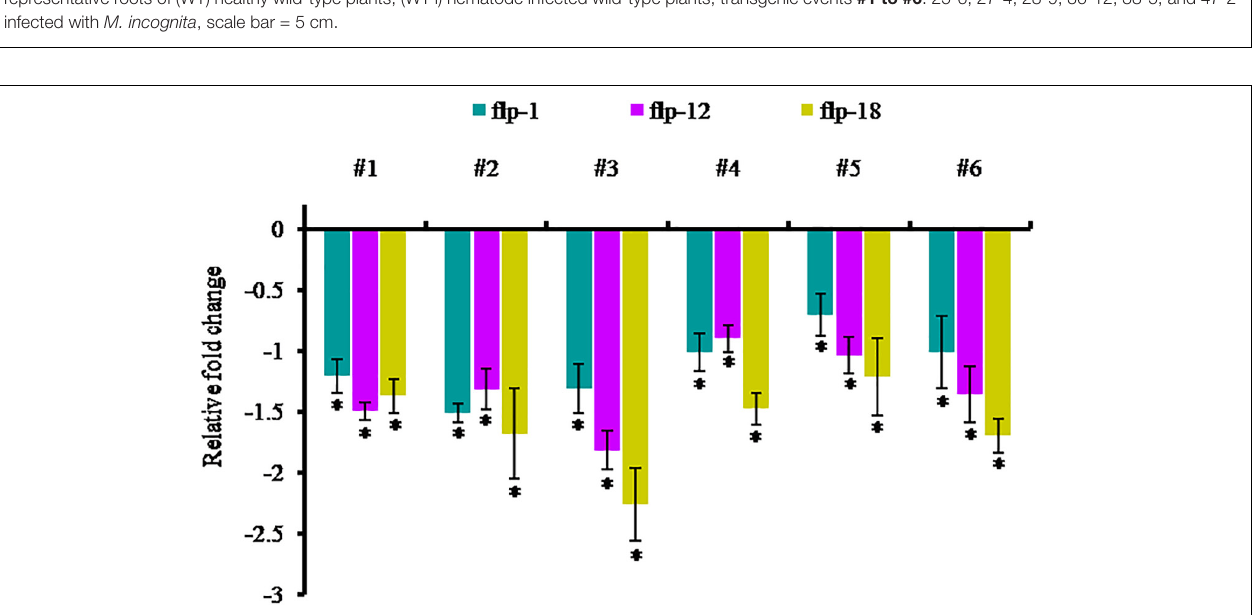
FIGURE 8 | Effect of host-delivered RNAi of FLPs-fusion gene on development and reproduction of M. incognita . (A) Performance of transgenic plants was assessed in terms of number of galls, total endoparasites, egg masses, eggs per egg mass, and multiplication factor (MF) in different transgenic lines ( #1 - 25-6, #2 -